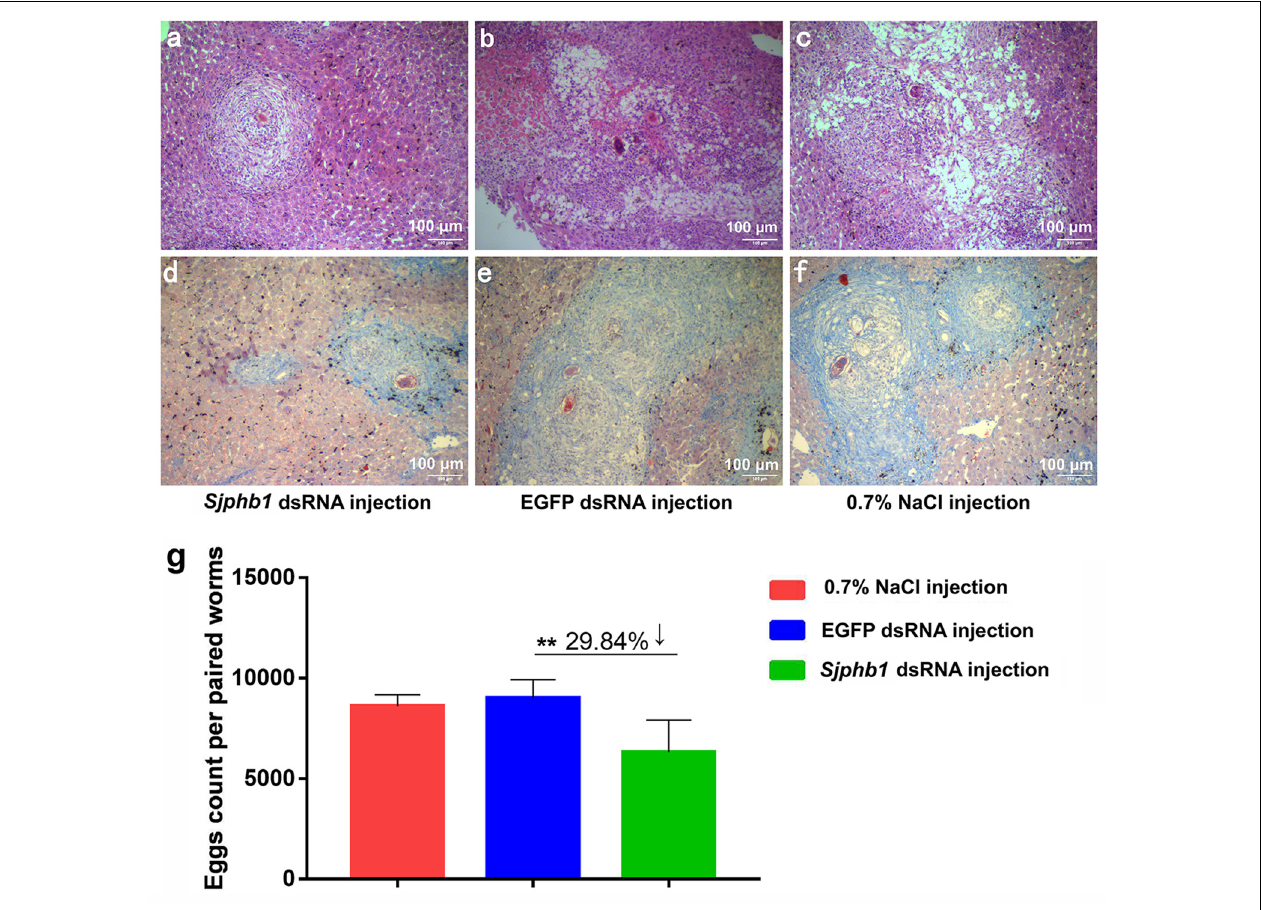
FIGURE 10 | dsRNA-mediated SjPhb1 knockdown in vivo resulted in a decreased egg production and attenuated granuloma formation and fibrosis in the liver of their mammalian host. (a–c) H&E staining of the mouse liver sections at 42 days post-infection (dpi). (d–f) Masson staining of the mouse liver sections at 42 dpi. (a,d) SjPhb1 dsRNA injection. (b,e) EGFP dsRNA injection. (c,f) 0.7% NaCl injection. (g) Comparison of egg count per paired worms per gram of the liver weight of mouse. ∗∗ P =